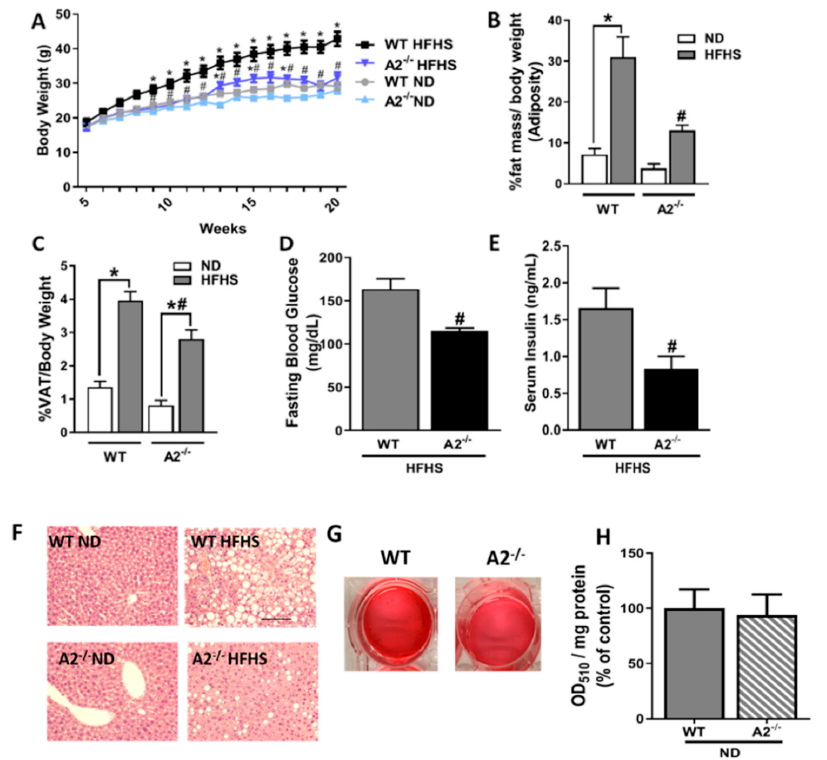
Figure 1. A2 deletion attenuates HFHS diet-induced increases in body weight, adiposity, VAT expansion, fasting blood glucose, postprandial serum insulin, and lipid accumulation in the liver without affecting adipocyte differentiation. Growth curves ( A ), n = 8–17 per group; percentage of body fat mass measured by nuclear magnetic resonance spectroscopy ( B ), n = 5–9 per group; percentage of VAT weight relative to body weight ( C ), n = 8–14 per group; fasting blood glucose ( D ) and fed serum insulin ( E ), n = 5–8 mice per group are shown for WT and A2 − / − mice. Values are represented as mean ± SEM. * P < 0.05 when compared to ND-fed mice within the same genotype, # P < 0.05 when compared to WT on the same diet. Representative photomicrographs of hemotoxylin and eosin-stained liver tissue sections from WT and A2 − / − after 16 weeks on HFHS or ND ( F ), scale bar = 50 μ M. Representative images of cytoplasmic lipid droplets in preadipocytes from SVF of VAT of WT and A2 − / − mice stained with Oil Red O after eight days of in vitro differentiation ( G ) and the corresponding quantification ( H ), n = 3 per group).